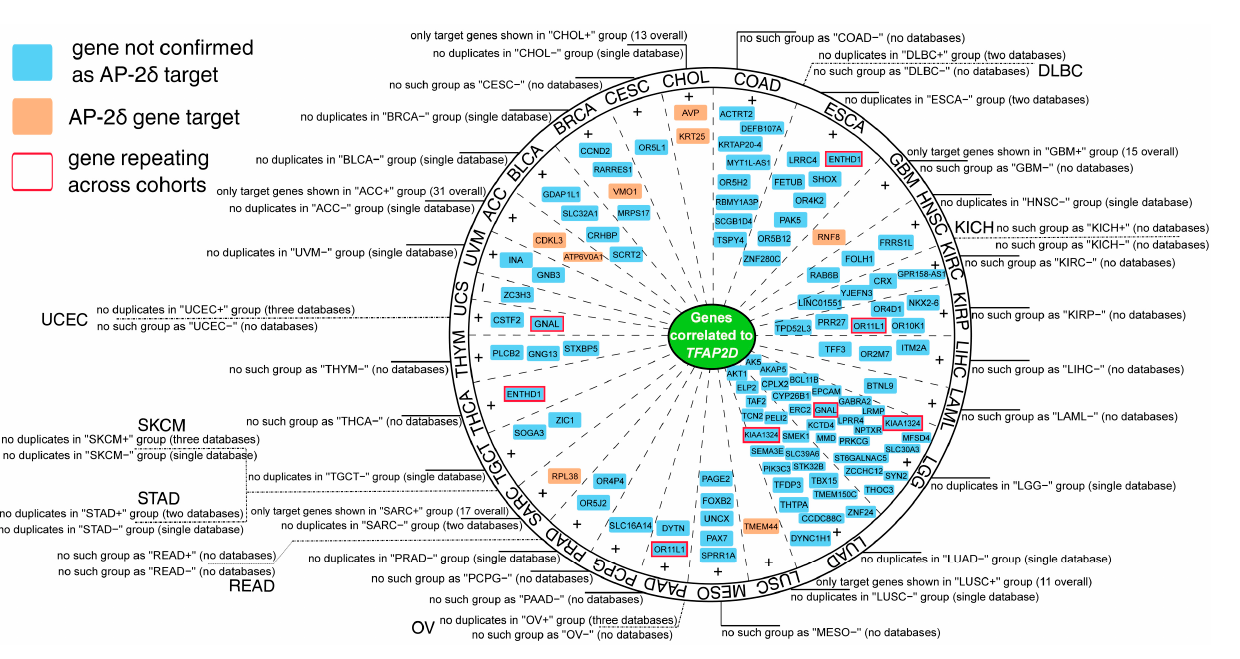
Figure 9. Summary of the most valuable data from within-cancer correlation analysis performed via cBioPortal, GEPIA2, CorrelationAnalyzeR, and UALCAN. Some cohorts revealed no qualifying genes, the cause could be a lack of duplicates across databases (e.g., SKCM), or no results were obtained from any database (e.g., UCEC). Some genes were denoted as AP-2 δ targets (orange) or the ones that repeat across cohorts (red frame). Details on data availability are provided around the circle and in Supplementary File S4.